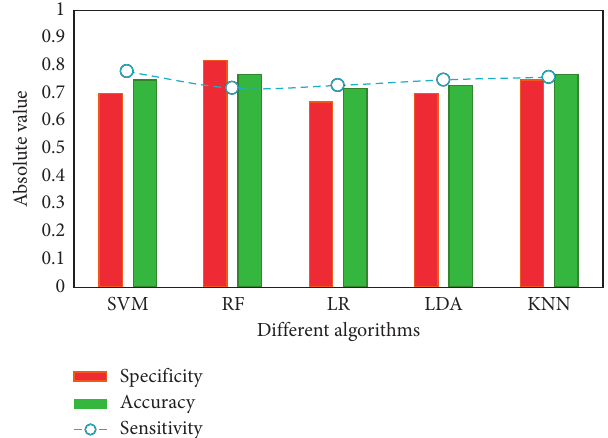
Figure 8: Results of five classification